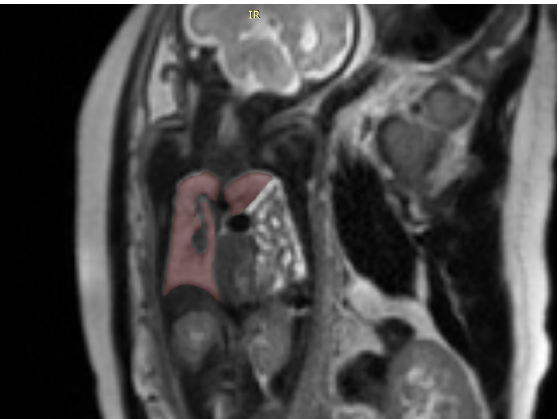
Figure 2. Coronal image of the fetus showing the tracing method for calculating the lung volume, using the ITK-SNAP program.